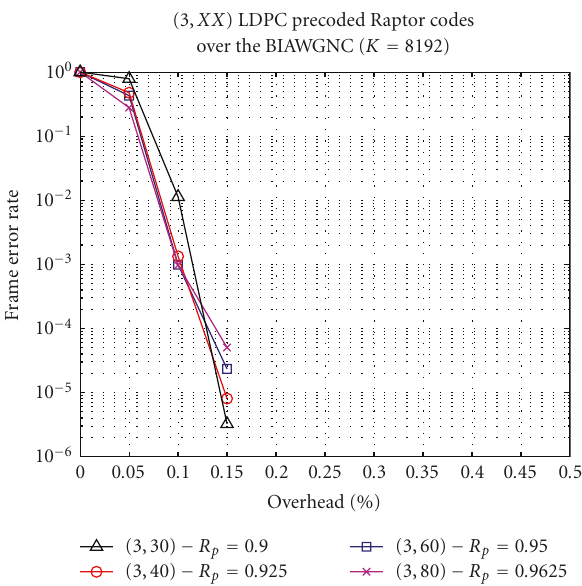
Figure 10: Performance of LDPC precoded Raptor codes of size K = 8192. With very little loss in the waterfall region, the precode of rate R p = 0 . 9 does not exhibit an error